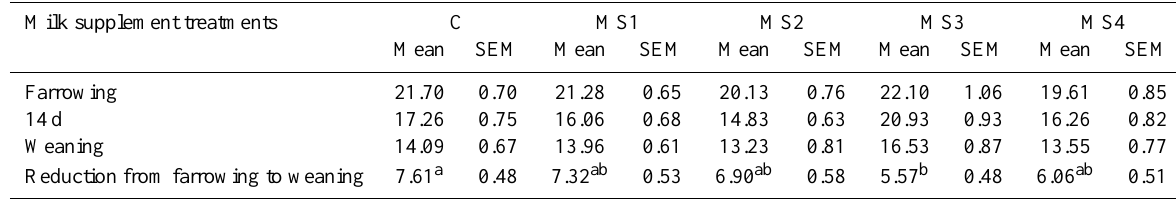
Table 4. The effect of feeding pigs with milk supplement on sow back-fat thickness (mm) change during the suckling period (number of sows = 30 in every